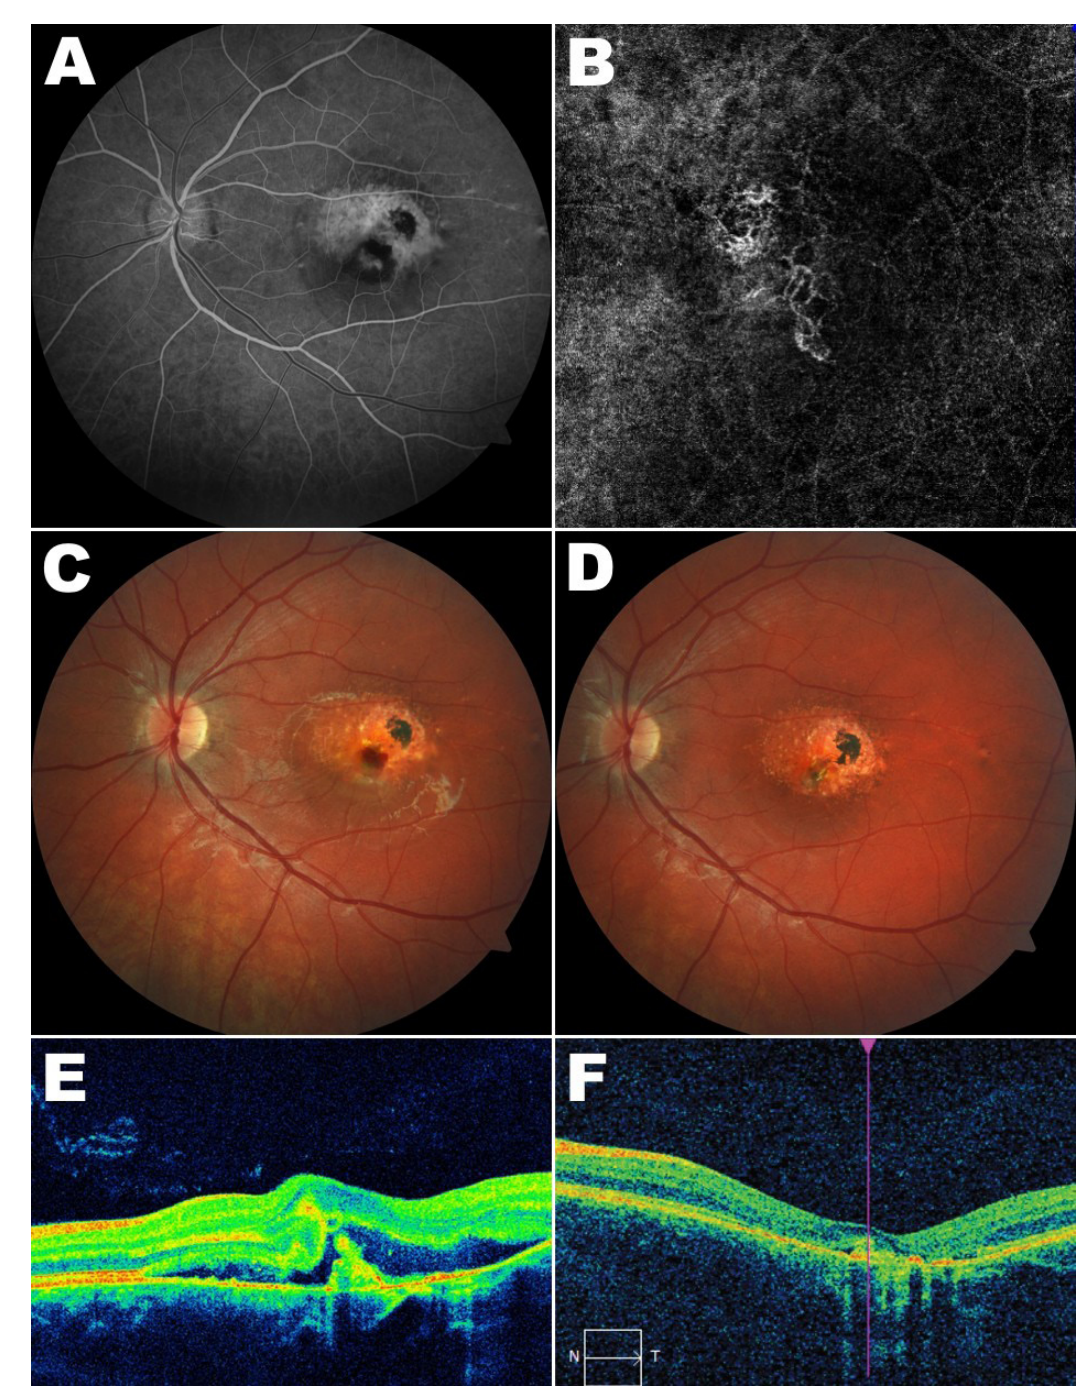
Fig. 4 A-F. Patient 6. 4A. Fluorescein angiography (FA) of the left eye, arteriovenous phase: gradually increasing hyperfluorescence due to classical submacular neovascularization in the lower part of the macula, blockade of fluorescence due to hemorrhages around the lesion, pooling of neuroretinal ablations, window defects of RPE. 4B. OCT angiography of the left eye, Type 2 of CNV in the avascular layer of the neuroretina. 4C. Fundus photog- raphy of the left eye. Circular plaques of coalescing yellowish-white masses, hypopigmented halos in the vicinity, gross pigment deposits and area of RPE atrophy with sub-macular haemorrhage due to CNV. 4D. Fundus pho- tography of the left eye after treatment. Disappearance of the submacular haemorrhage, improvement. 4E. OCT of the left eye before treatment, OCT scan shows an inaccurately delineated lesion of mixed moderate reflectivity in the lower part of the macula with serous parafoveal neurosensory detachment, area of the RPE damage and 4F. improvement after antiVEGF